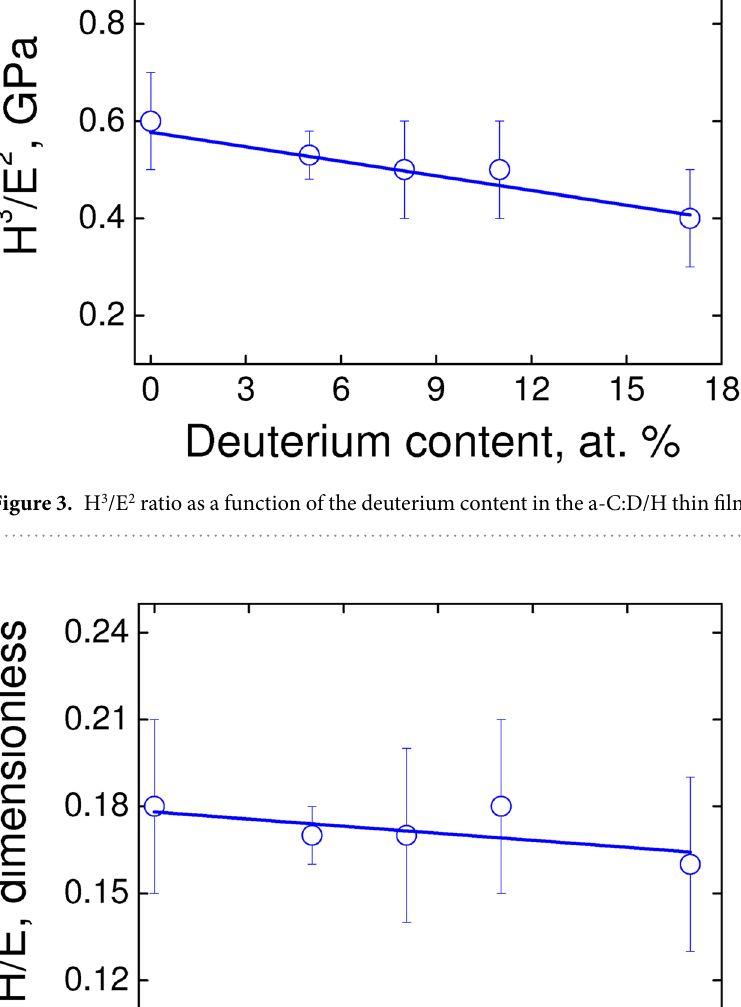
to elastic strain) the higher the energy dissipation. Consequently, a detailed analysis of both ratios can determine the real contribution of mechanical properties in the coefficient of friction. As shown in Fig. 3, the H 3 /E 2 ratio (plastic deformation index) diminishes up to 30%, which indicates that the highest dissipation energy must be expected for the sample with the highest deuterium content. Such an interpre- tation goes in the opposite way because we observed a lower coefficient of friction, i.e., a lower dissipation energy as higher the deuterium content. As shown in Fig. 4, the H/E ratio (elastic deformation index) diminishes up to 7%, amount representing a lower value than the experimental error (higher than 10%). Thus, the energy dissi- pation through an elastic deformation mechanism is roughly constant, independently of the deuterium content. According to these experimental evidences, the observed tendency in our results for an irreversible process of friction is not being conducted neither through plastic nor elastic deformation mechanisms as the main dissi- pation channel. Regarding the roughness, they are quite similar among samples ruling out interferences on the friction forces measurements. One must notice that the hardness slightly decreases with the increasing of the deu- terium content (see Table 1) and consequently a higher tip contact area is expected. Therefore, a higher contact area should increase the friction forces, an effect that we did not observe in the experiments. Thus, a softer a-C:D